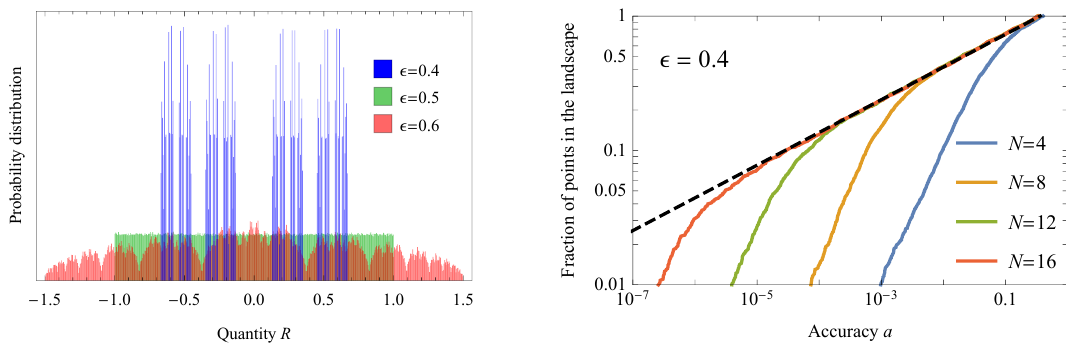
Figure 5 . Left: distributions of a generic quantity R given by the landscape of eq. (5.1) at large N and for (cid:15) < 1 = 2 (blue fractal), (cid:15) = 1 = 2 (green (cid:13)at), (cid:15) > 1 = 2 (red non smooth). A wide Gaussian would be obtained for (cid:15) = 1. Right: fraction of the parameter space covered in fractal landscapes for di(cid:11)erent N